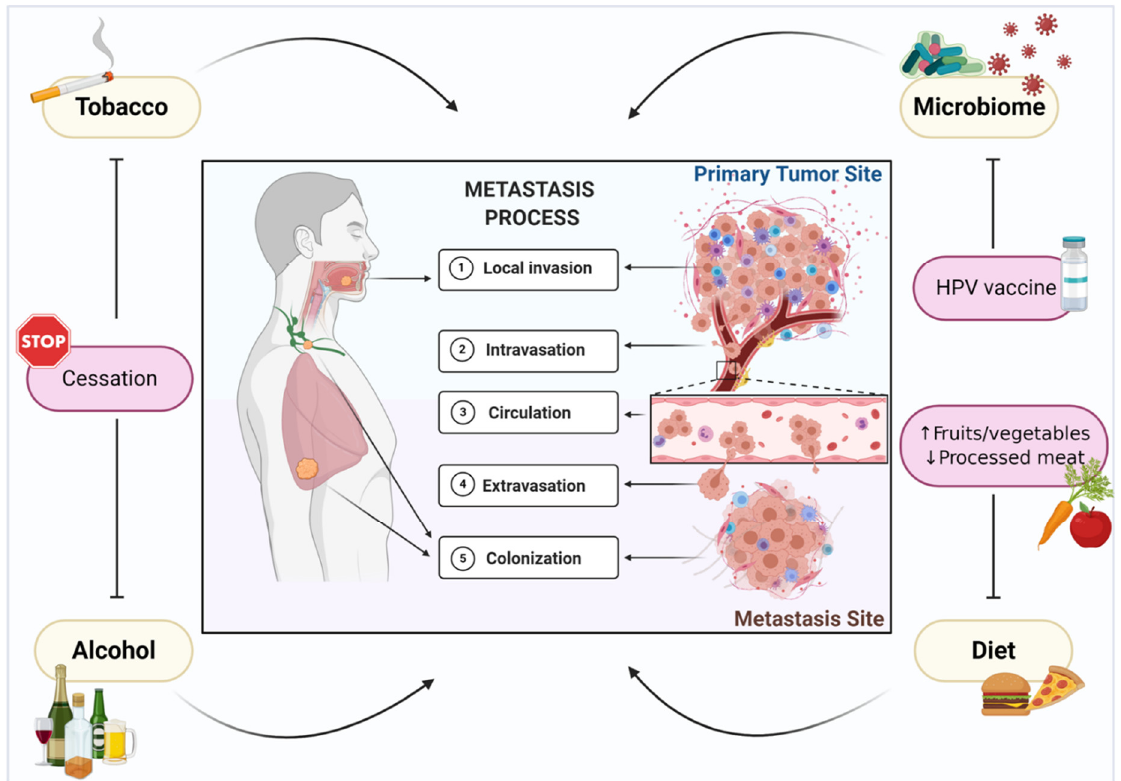
Figure 1. Environmental factors support metastasis of head and neck cancer. Metastasis is a complex and multi-step process that is orchestrated by tumor biology and supported by external environmental factors, such as tobacco and alcohol consumption, human papillomavirus (HPV) infection, the microbiome, and diet, which are involved in tumor cell invasion, intravasation, circulation, extravasation, and metastatic colonization. A precision-based model of metastasis prevention centered around modifiable risk factors involves smoking and alcohol cessation, HPV vaccination, and a diet that is high in fruits and vegetables and low in processed and red meats.